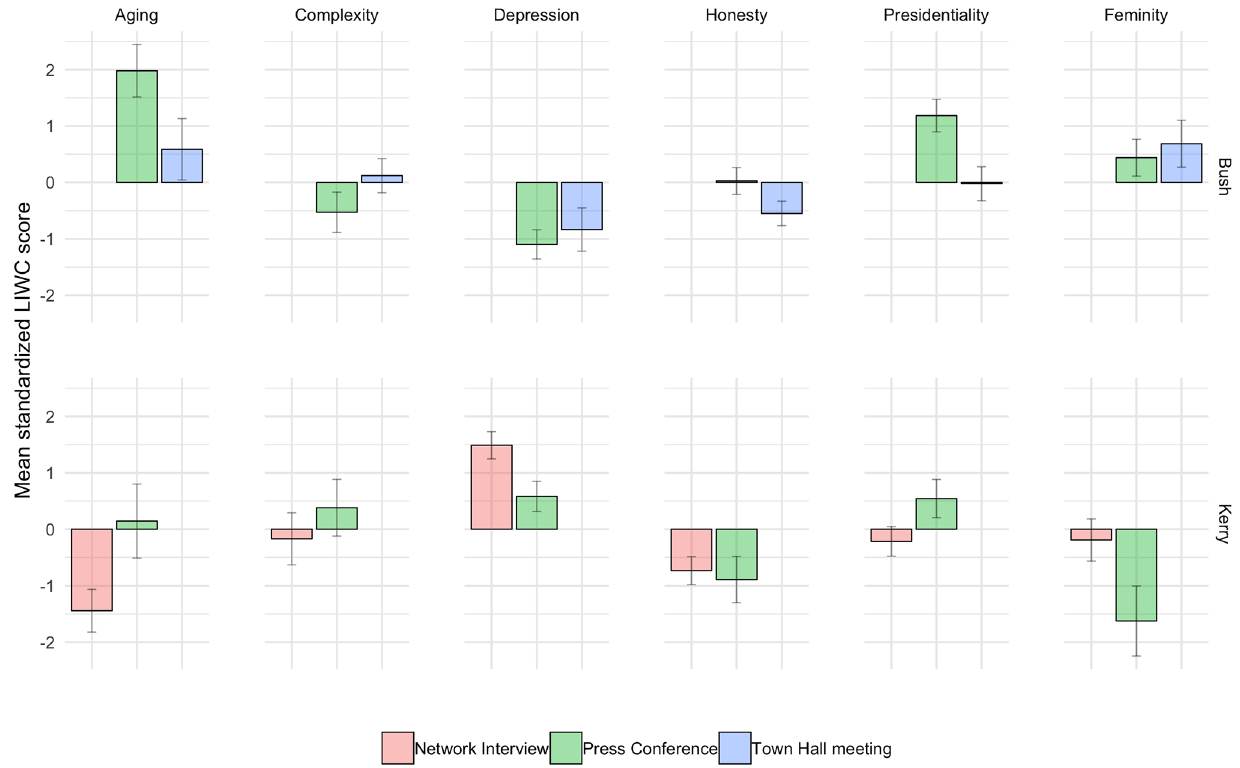
Figure 1. Linguistic style of George W. Bush and John Kerry on six linguistic style dimensions. Note. This figure displays standardized LIWC scores for George W. Bush and John Kerry on six linguistic style dimensions (aging, complexity, depression, honesty, presidentiality, feminity) for various text sources for which we have at least 10 observations: network interviews (Kerry: n = 44), press conferences (Bush: n = 57: Kerry: n = 21), and town hall meetings (Bush: n = 38) (for more information, see Slatcher et al.,